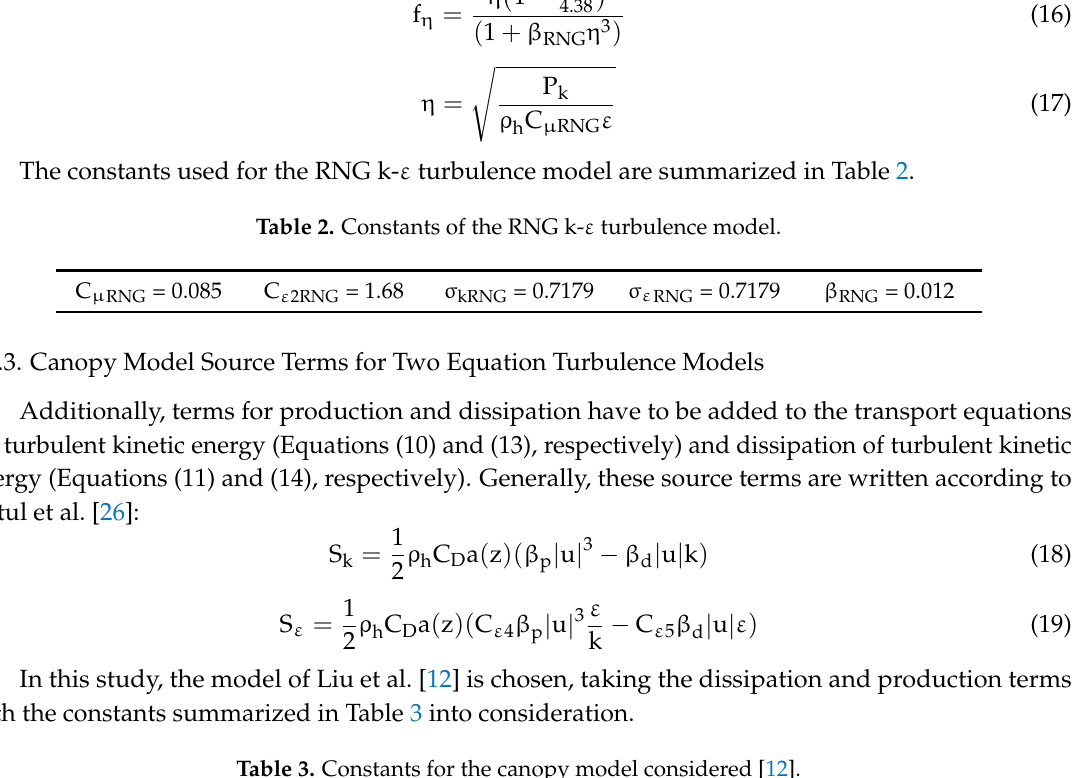
Table 3. Constants for the canopy model considered